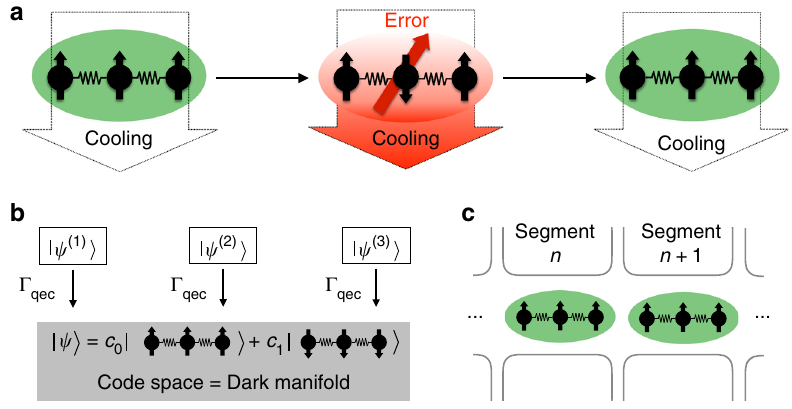
Fig. 1 Dissipative realization of a three-qubit code in trapped ions. The unknown state | ψ 〉 = c 0 | 000 〉 + c 1 | 111 〉 is encoded in the internal states of three ions and protected against single spin- fl ips by means of engineered couplings to a quantum reservoir that consists of motional modes. a Spin- fl ip errors are continuously removed from the system through cooling of the motional modes. b Compromised states ψ ð j Þ logical subspace at a rate Γ qec , while the code space is a dark manifold of the engineered dissipative processes. c The scheme can be scaled up to several logical qubits using a segmented trap (Supplementary Note